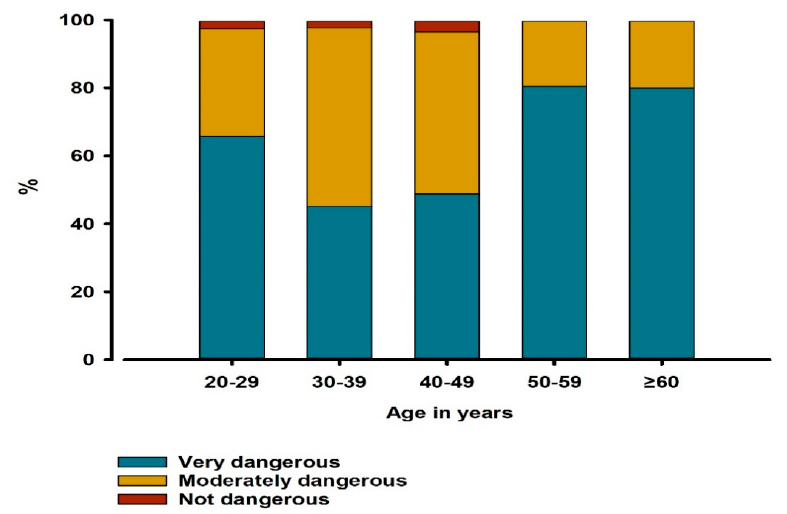
Figure 1. Distributions of different risk perception categories among different age groups of participants ( n = 269). The relationship between age in years and risk perception of COVID-19 was assessed by chi-square test ( p = 0.004).